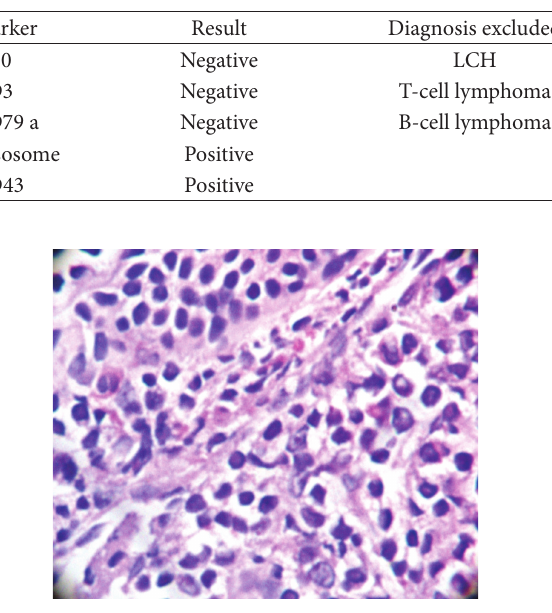
Table 1: Immunohistochemical markers used to rule out the differential diagnosis in our case.